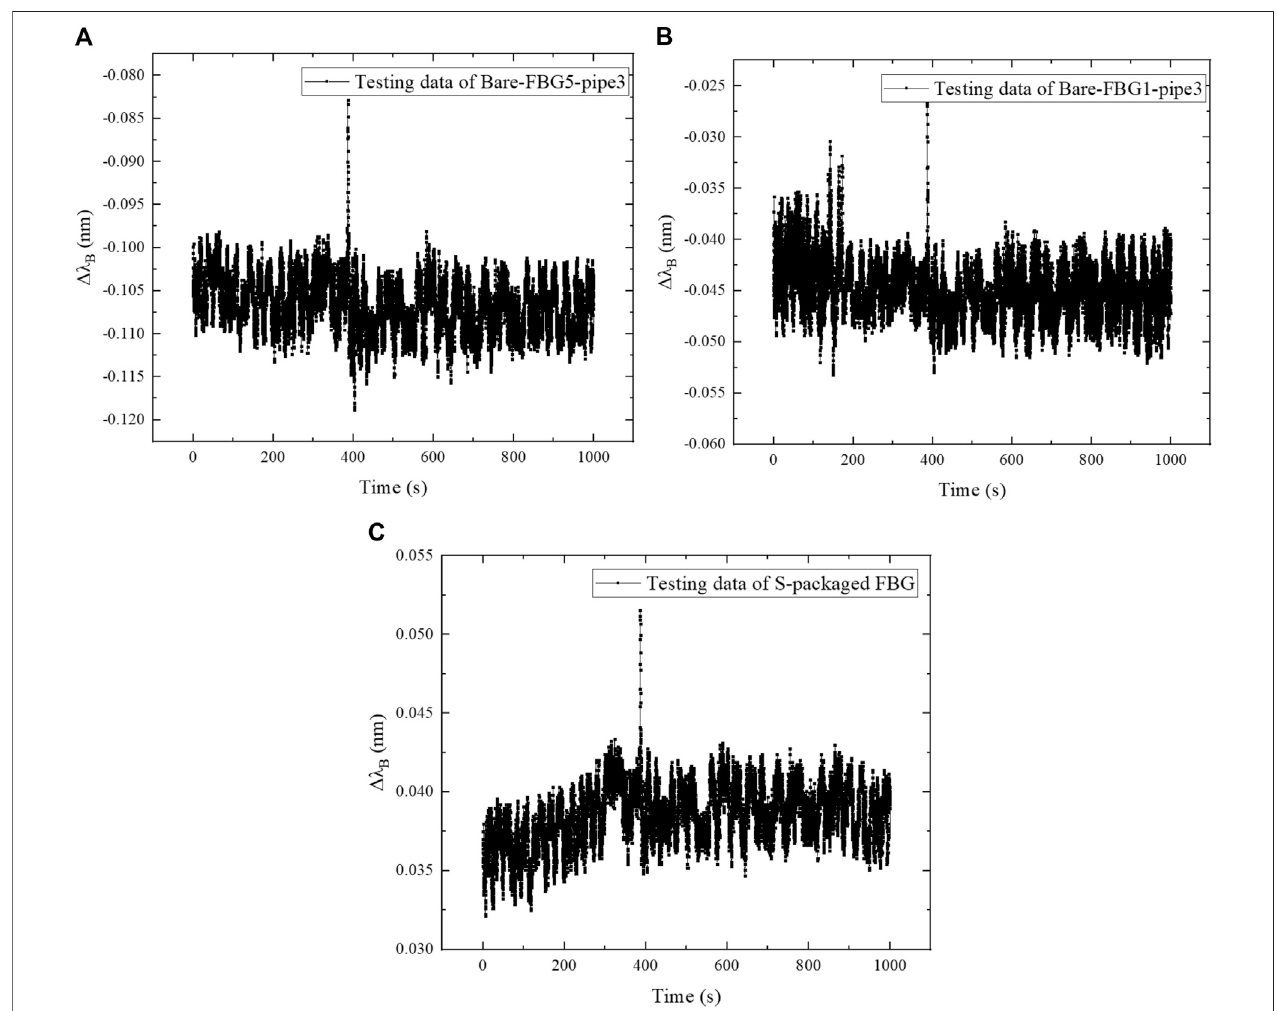
FIGURE 10 | Relationship of central wavelength increment with loading time at 20 Hz: (A) Bare-FBG5-pipe3; (B) Bare-FBG1-pipe3; (C) S-packaged FBG.